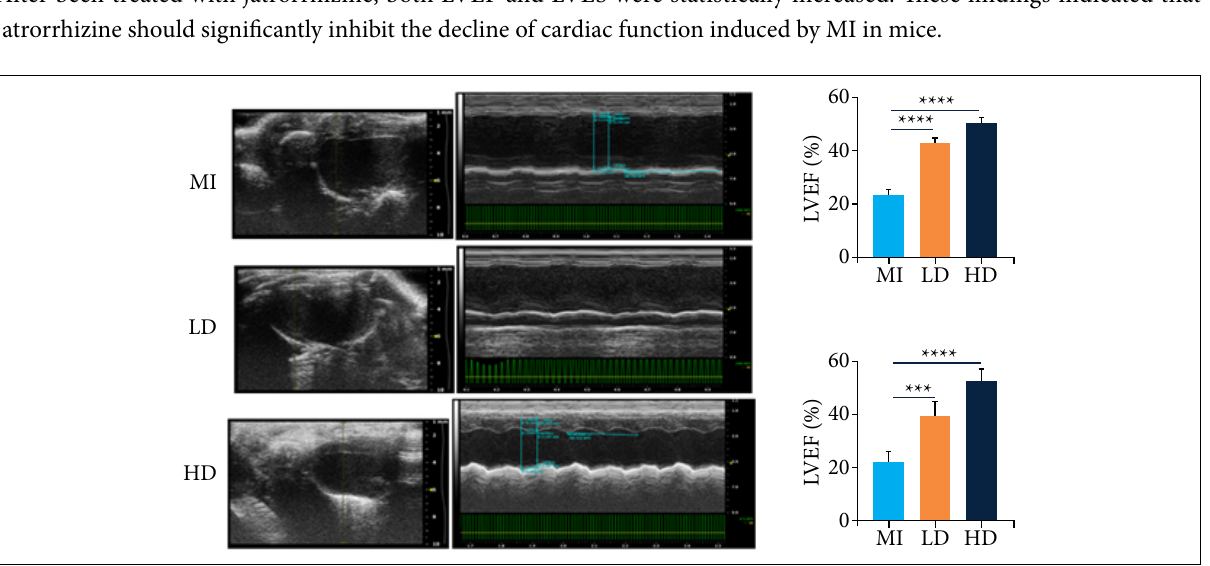
Figure 1 - Effect of jatrorrhizine on LVEF and LVES of mice with MI.